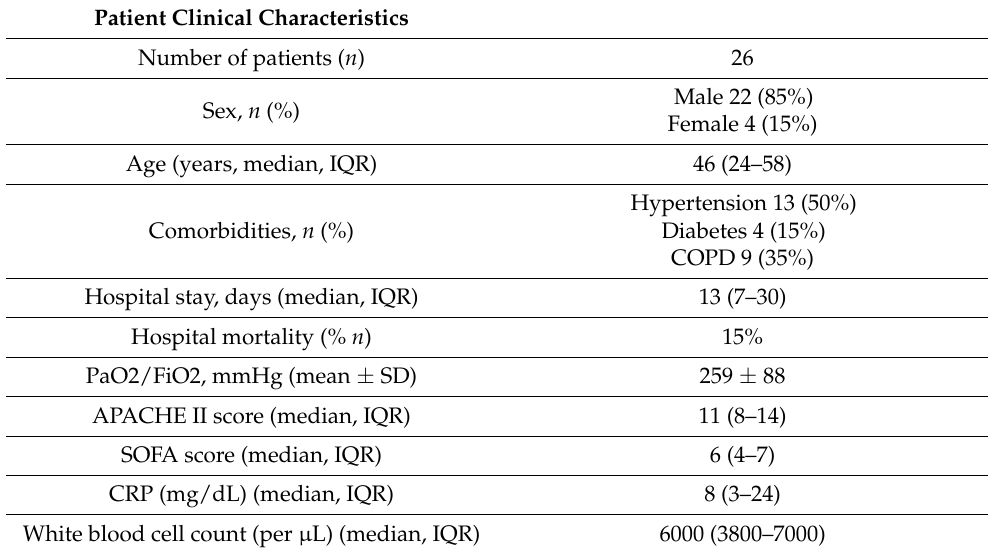
Table 1. Clinical characteristics and laboratory data of the patients included in the study.